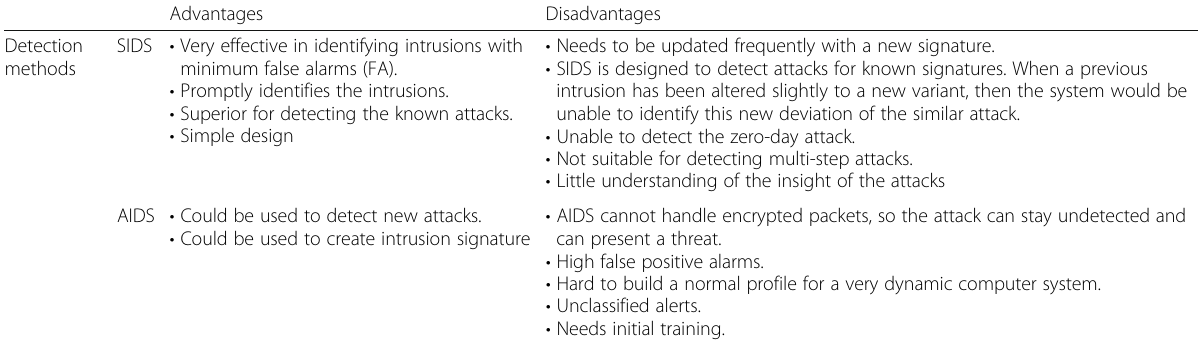
Table 2 Comparisons of intrusion detection methodologies Advantages Disadvantages Detection